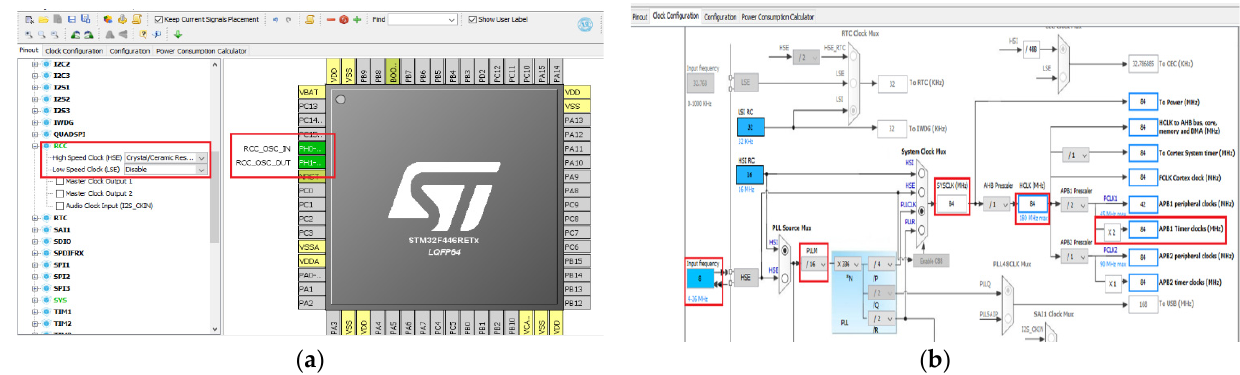
Figure 10. ( a ) Reset and control clock (RCC); ( b ) working frequency setup.